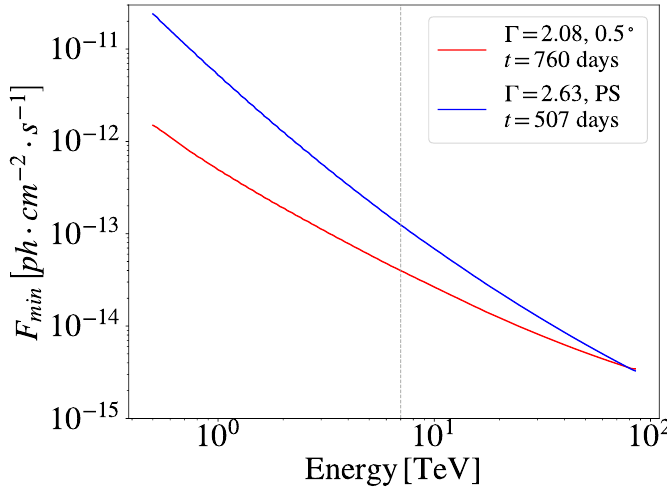
Figure 2. HAWC minimum flux, F min , needed to reach source detection ( TS = 25) at a sky declination equal to 30.87 ◦ . In blue, the F min as originally reported in [62] for the case of a point source described by a power law spectrum with index Γ = 2.63 and 507 days of exposure. The red curve shows the F min for our DM subhalo candidate instead (with a spatial extension of 0.5 ◦ , Γ = 2.08 and 760 days of exposure). This one is computed taking into account (i) the improvement factor of ∼ 5 derived for this unID at a pivot energy of 7 TeV [46], marked in the figure as a dashed grey vertical line; (ii) the √ difference in exposure times, which makes the F min improve by a factor 507/760 = 0.82; and (iii) a factor ∼ 2 worsening due to the extension of the source, according to [34]. See text for further details on these computations. The overall F min improvement is roughly an order of magnitude at low energies, while at the highest energies there is no improvement at